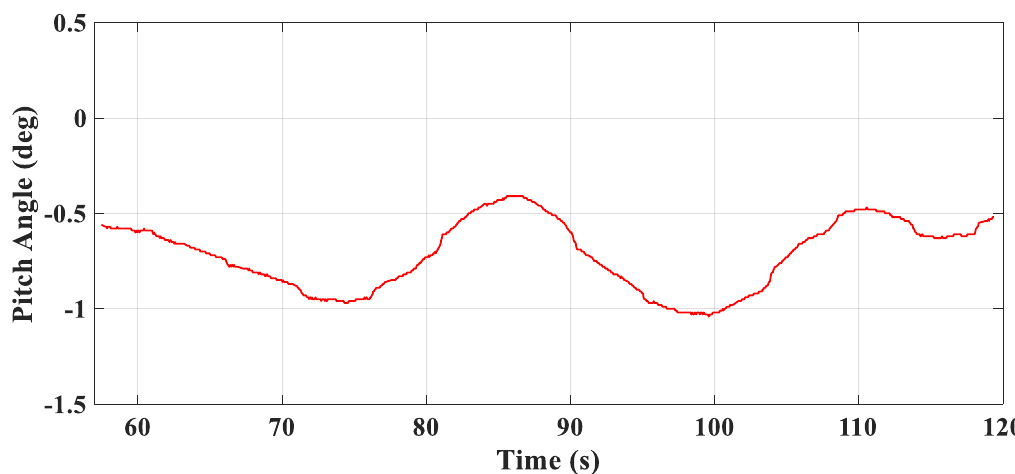
Figure 19. Pitch angle response of the vehicle at the stage of fins control.